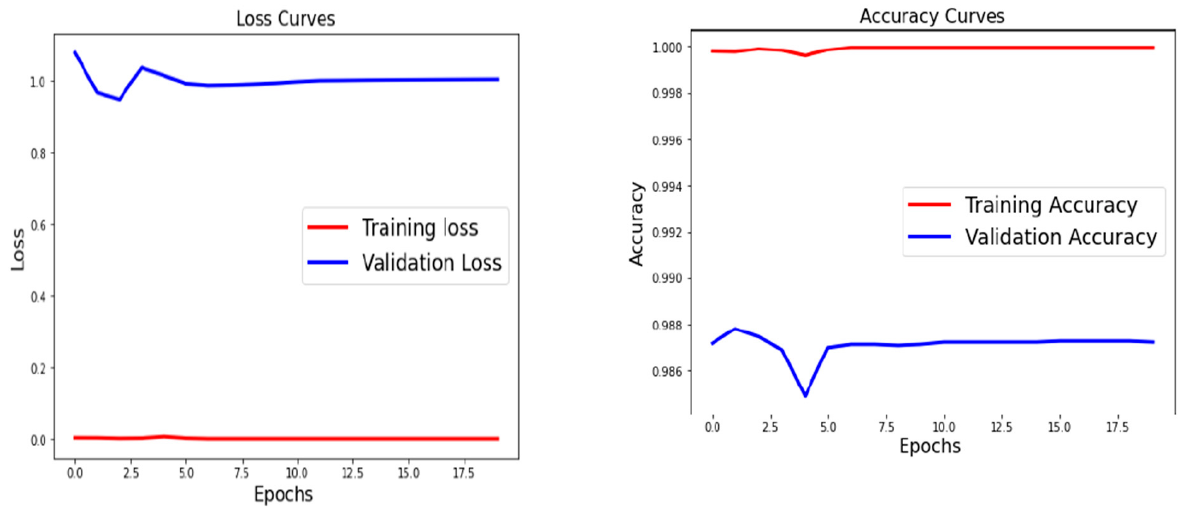
Figure 6. Graphs of the loss and accuracy curves for the feed-forward network.